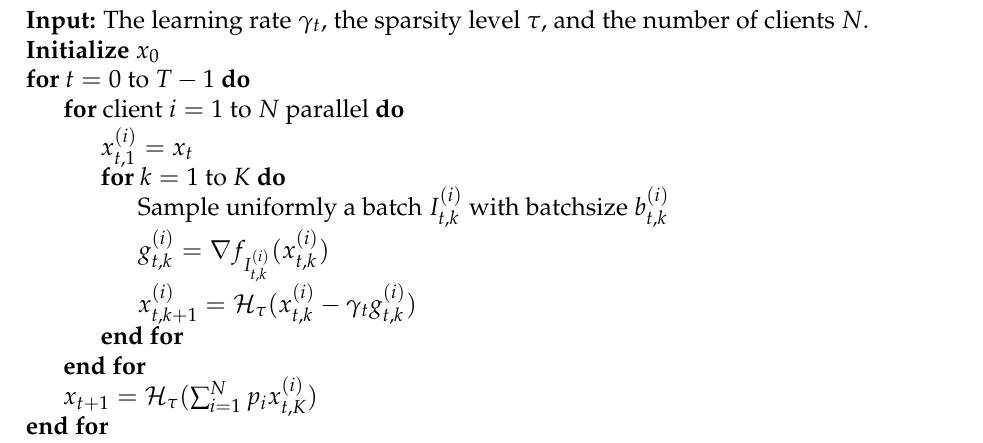
Algorithm 2 Federated Iterative Hard Thresholding